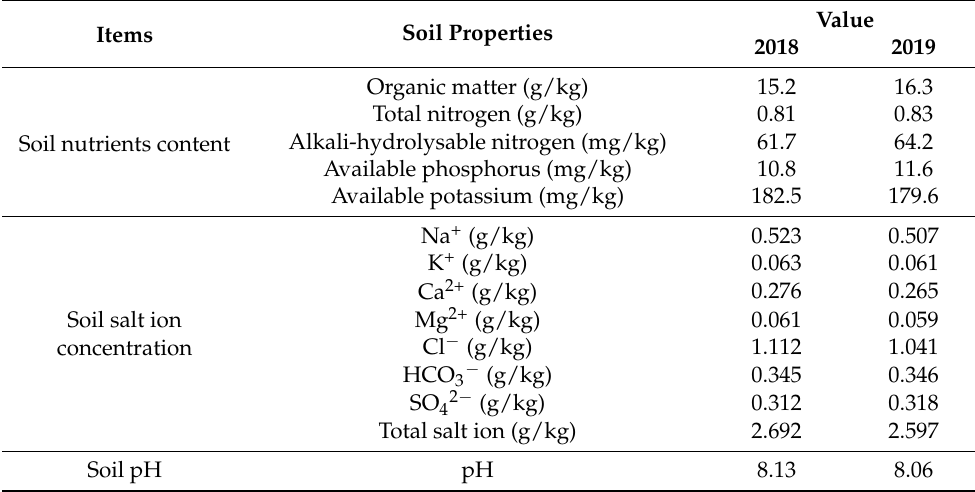
Table 1. The basic properties of soils (0–20 cm) in the study.